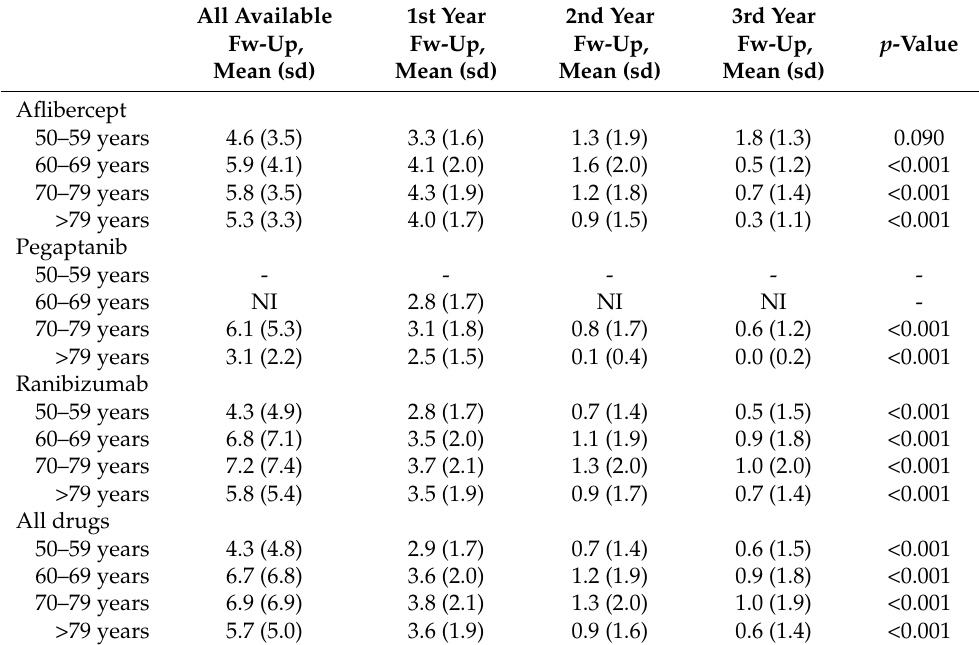
Table 3. Mean number of annual anti-VEGF prescriptions/patient during the follow-up among the wAMD-cohort stratified by age ranges.